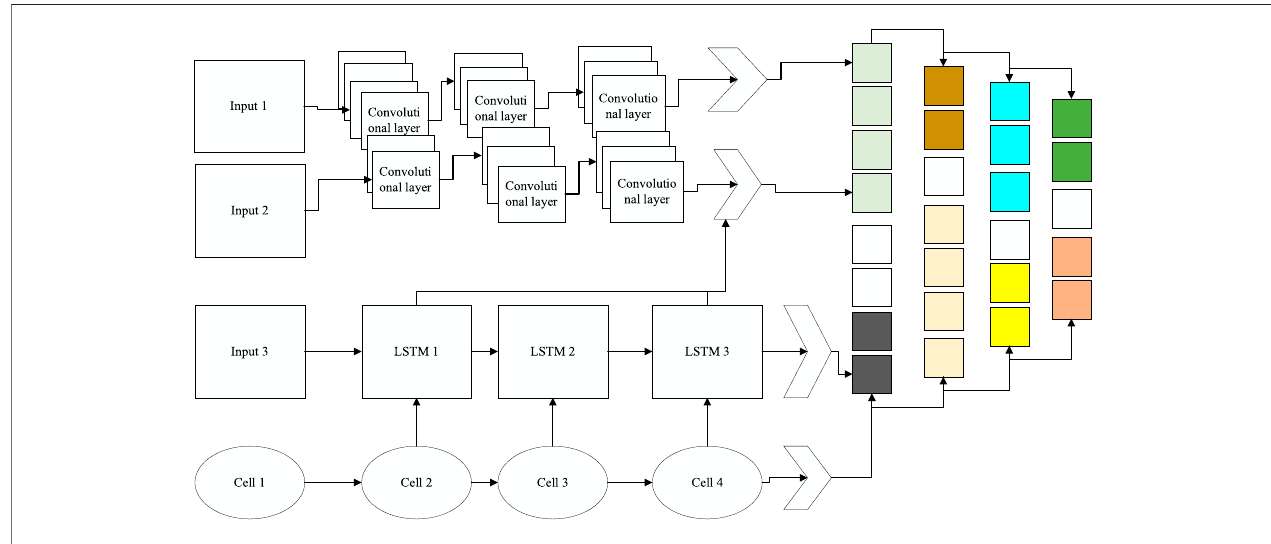
FIGURE 5 | Multi-stream network